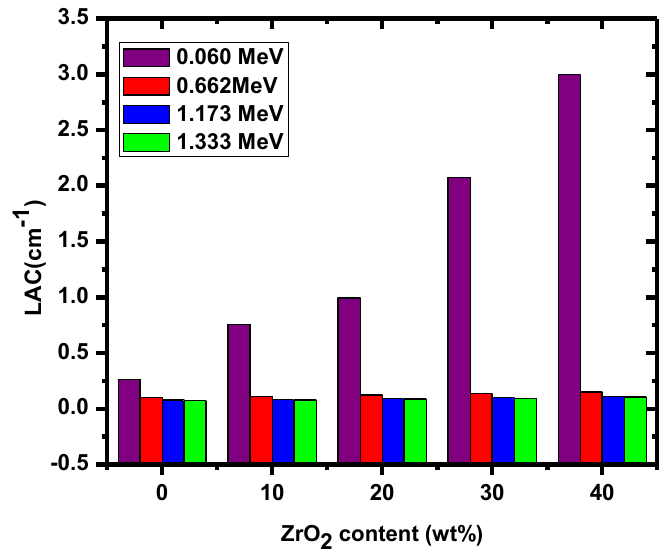
Figure 4. The variation of the LAC values of epoxy with ZrO 2 .